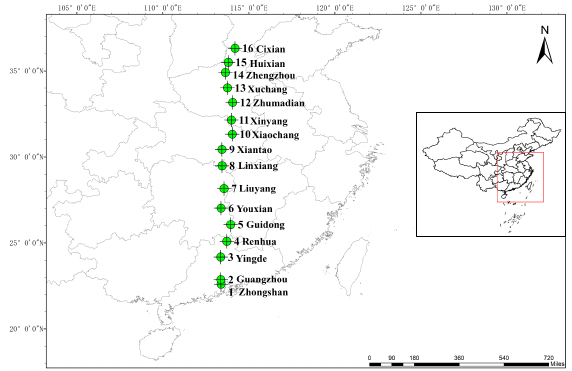
Figure 5. Distribution of C. dactylon populations in southeastern China. The green dot represents the sampling sites of transcriptome